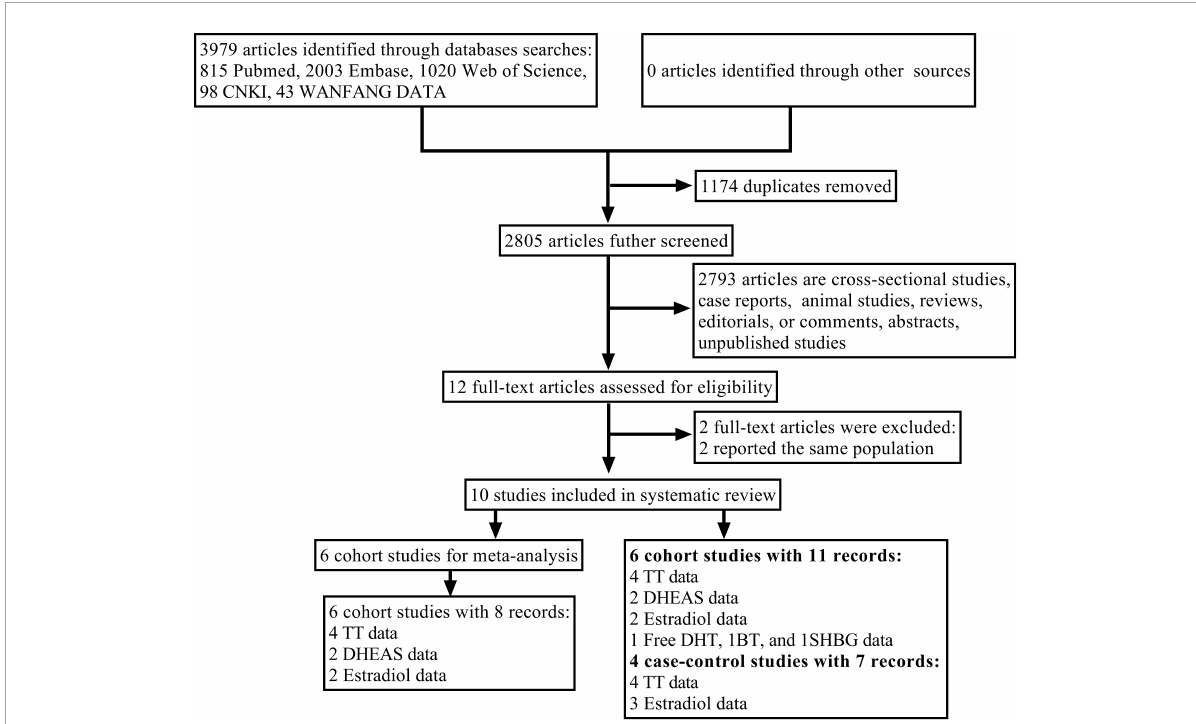
FIGURE1 Flowchart of the study selection process. AF, atrial fibrillation; BT, bioavailable testosterone; DHEAS, dehydroepiandrosterone sulfate; free DHT, free dihydrotestosterone; SHBG, sex hormone binding globulin; TT, total